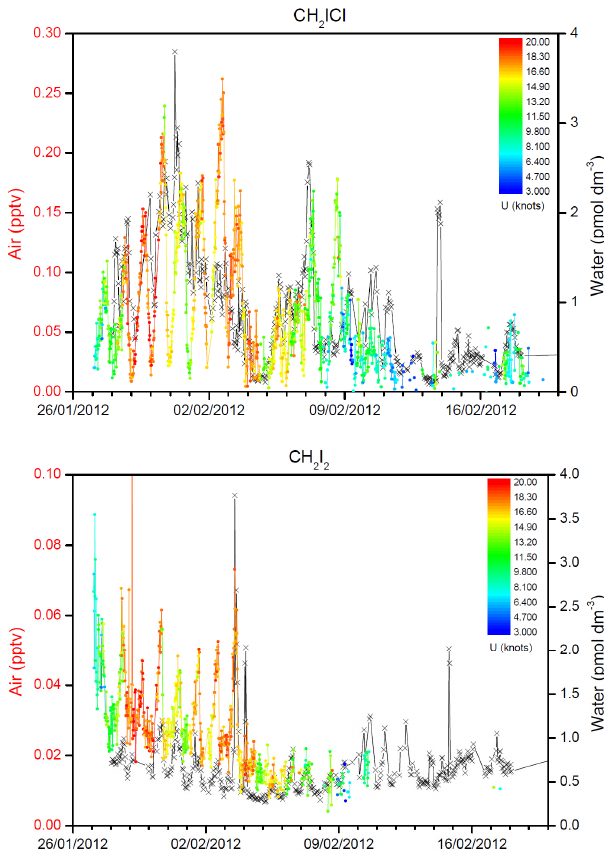
Figure 6. Example fieldwork data from the eastern tropical Pacific using the AutoP&T system. Air concentrations (squares coloured by wind speed) are plotted with water concentrations (black crosses) for CH 2 ICl (top) and CH 2 I 2